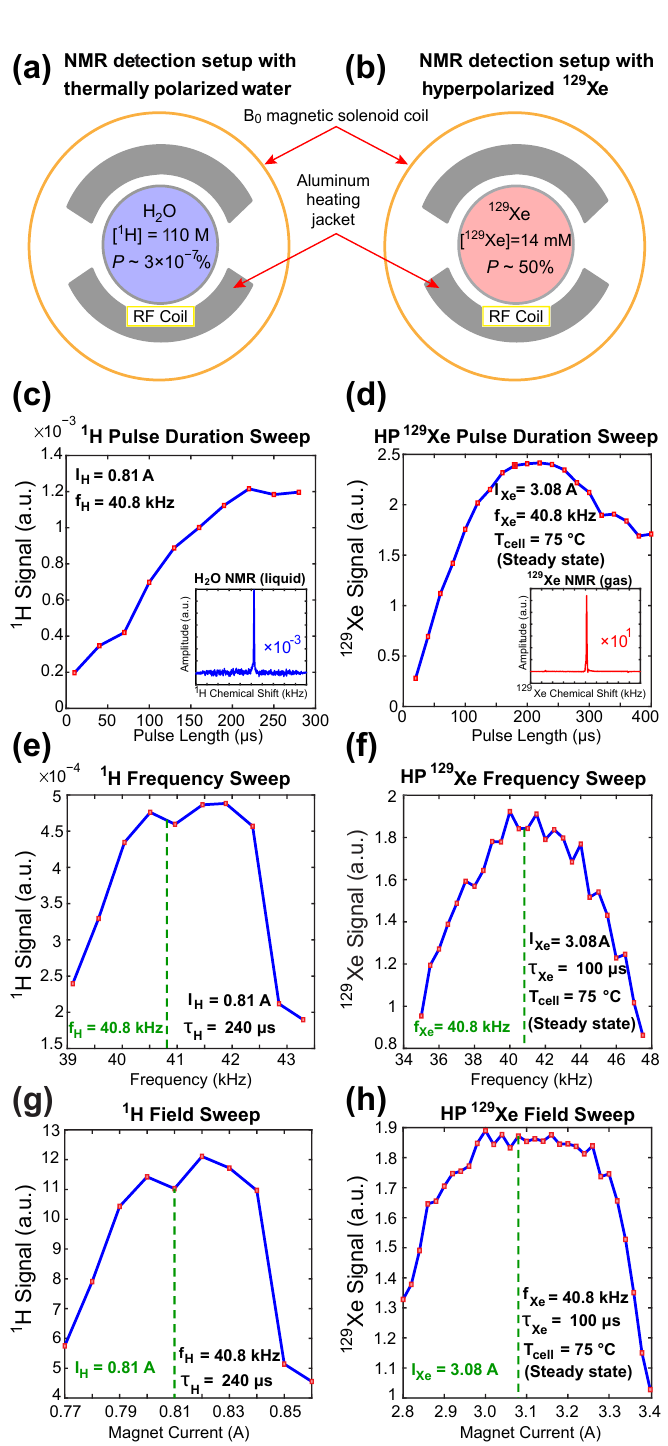
Figure 3. Schematic representation of the 1 H ( a ) and 129 Xe ( b ) sample arrangements. Displays ( c , d ) show RF pulse duration sweep for thermal 1 H and HP 129 Xe, respectively, with NMR spectra shown as inserts. Displays ( e , f ) show NMR signal intensity as a function of resonant frequency for thermal 1 H and HP 129 Xe, respectively, at fixed magnetic field current. Displays ( g , h ) show NMR signal intensity as a function of magnetic field driver current for thermal 1 H and HP 129 Xe samples, respectively. For protons, the ~1 mT field is swept over the 10% range reflecting the maximum possible fluctuation due to polarizer magnet alignment with the Earth’s magnetic field of ± 0.05 mT. Note, RF amplifier outputs a 3.6-fold higher voltage for 129 Xe RF excitation pulses compared to that for proton RF pulses to compensate for the difference in gyromagnetic ratios of the